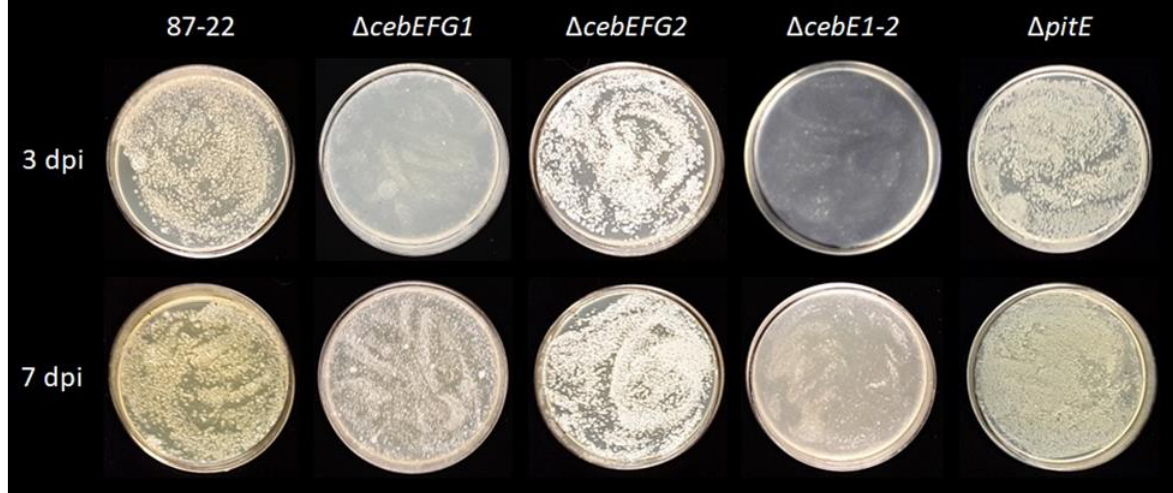
Figure 4. Growth of wild type (87-22) and transporter deletion mutant strains on minimal medium supplemented with cellobiose as the sole carbon source at 3 and 7 dpi. Note that the growth delay was only observed when genes of the ceb 1 cluster are deleted (mutants Δ cebEFG1 and Δ cebE1-2).